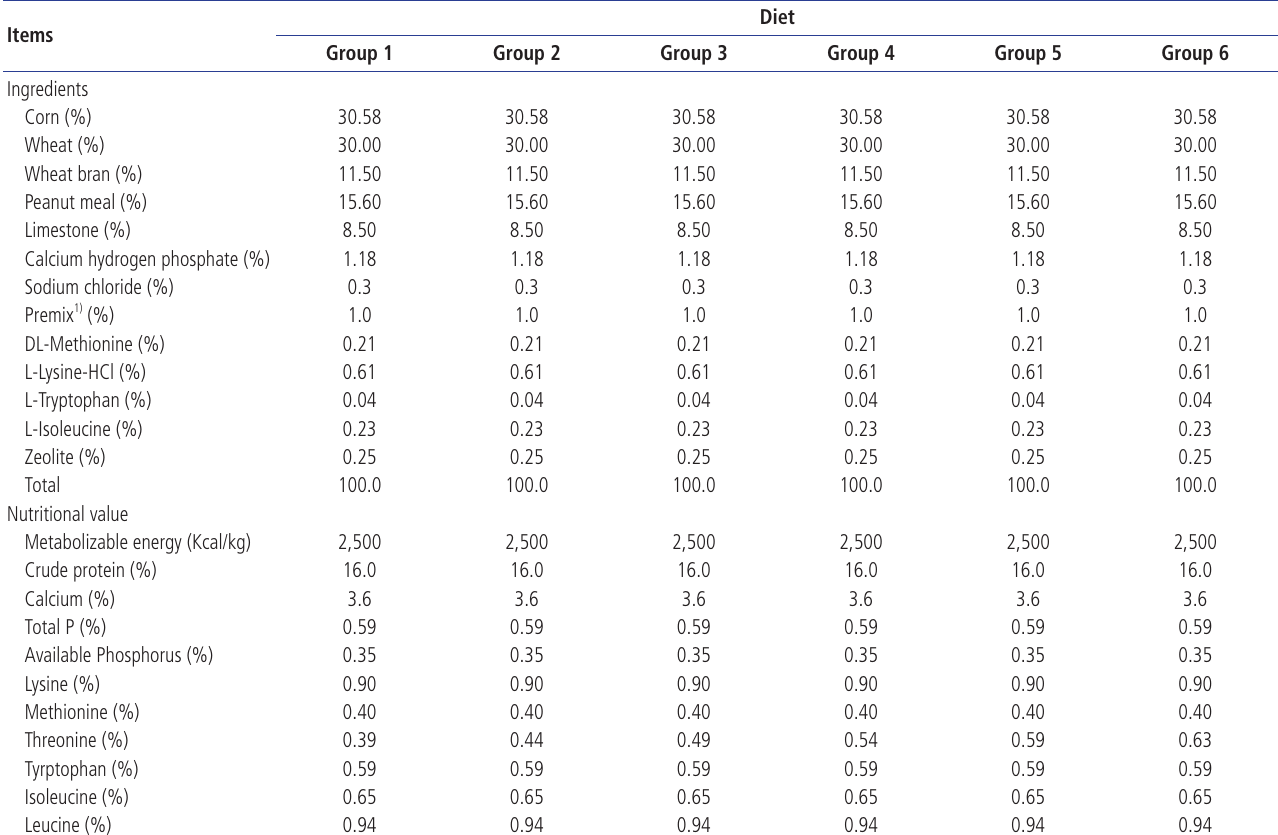
Table 1. Composition of the experimental diets and nutrient